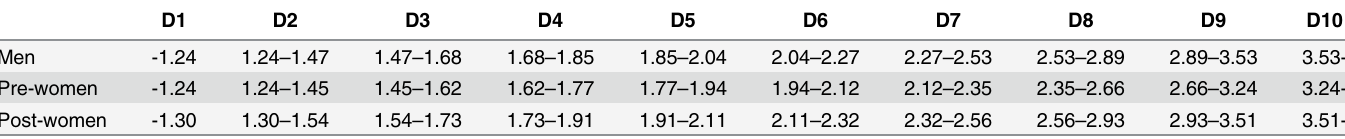
Table 2. HOMA-IR values divided by 10 decile.